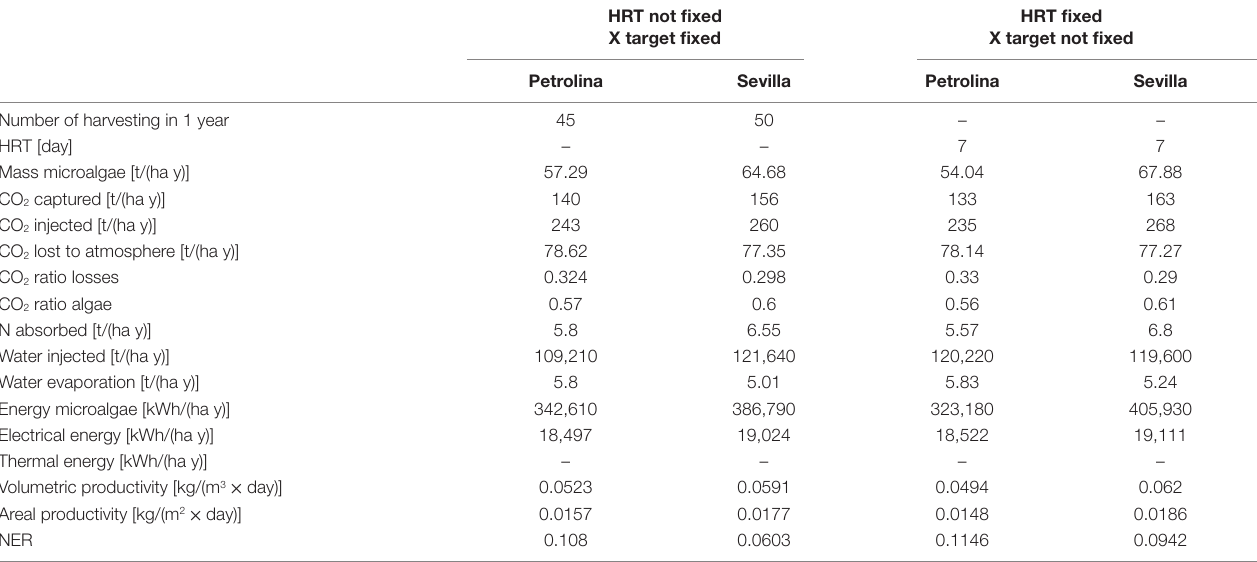
TaBle 5 | Output from open pond